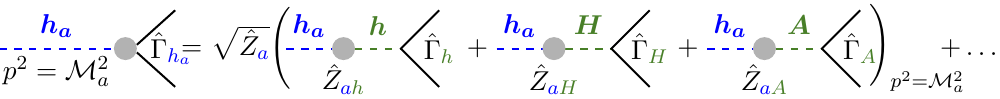
Figure 1 . ^ Z -factors for external Higgs bosons: the vertex function ^(cid:0) h functions ^(cid:0) i ; i = h; H; A , the transition factors ^ Z ai and the overall normalisation factor ellipsis refers to contributions from mixing with Goldstone and gauge